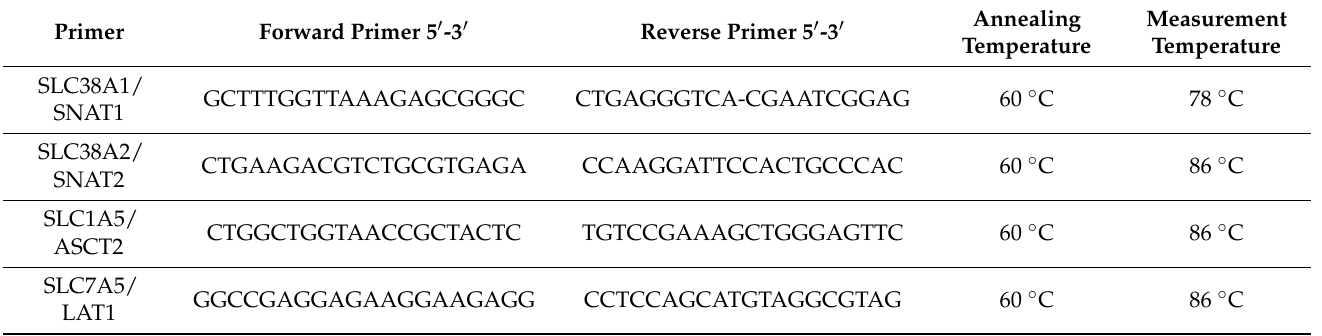
Table 2. Primers for